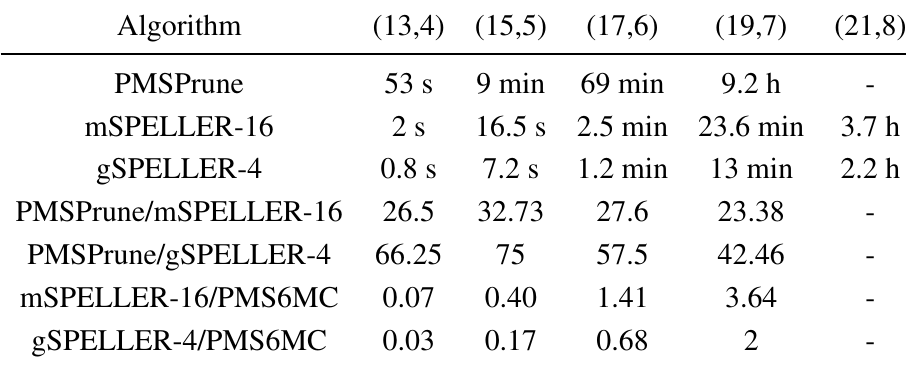
Table 5. Comparing mSPELLER and gSPELLER with